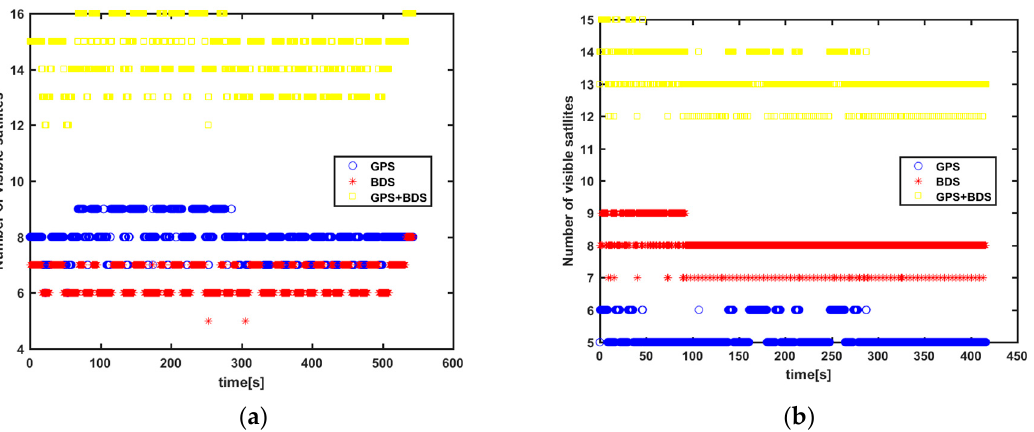
Figure 13. The number of visible satellites in field tests (15° elevation mask). ( a ) Test 1; ( b ) test 2.